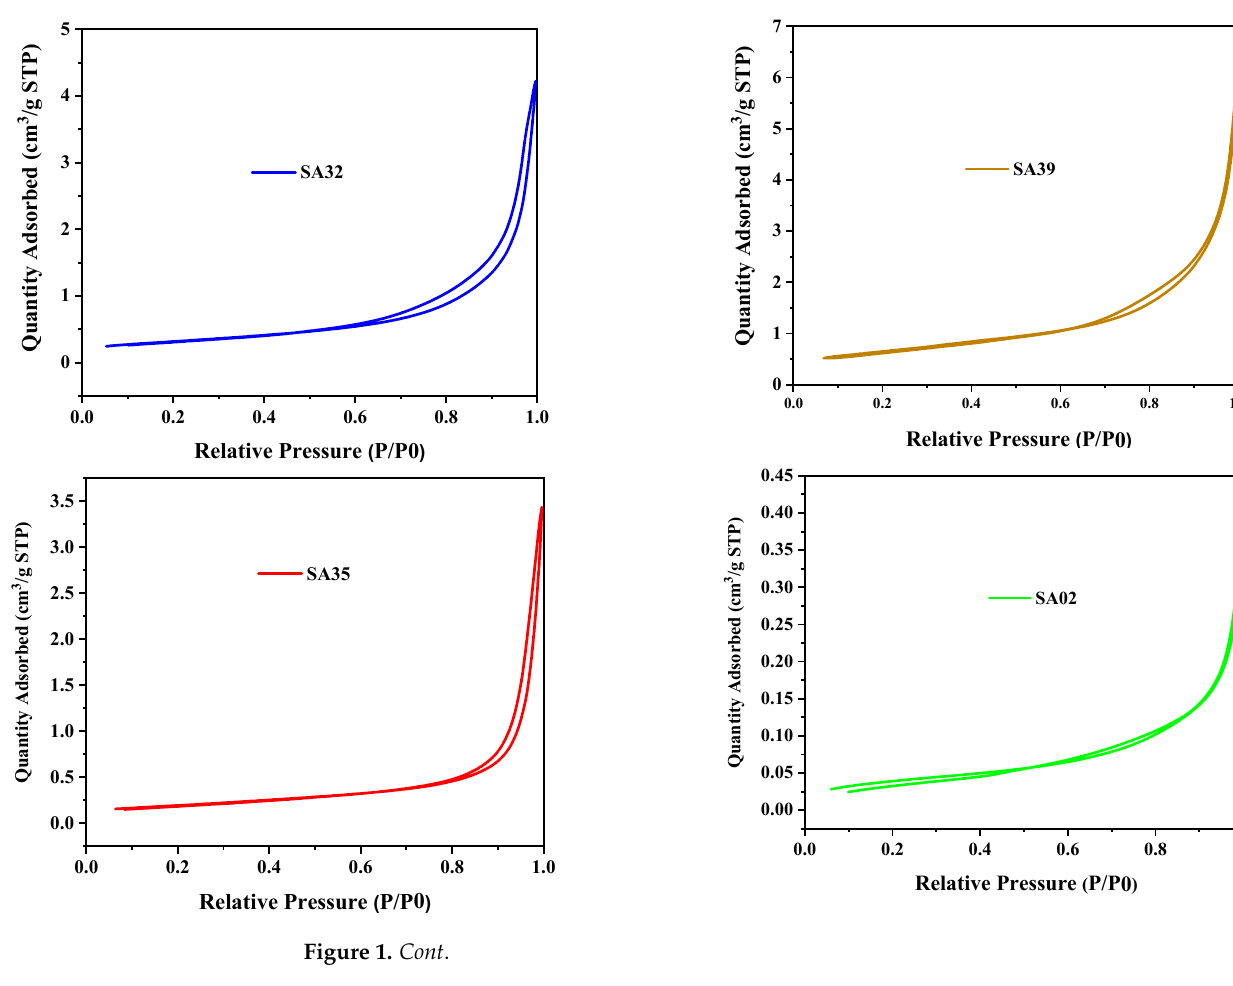
Figure 1. N 2 adsorption–desorption measurements of fresh Ni-supported catalysts. 2.2. TPR H 2 -TPR (temperature-programmed reduction) curves of the fresh catalysts are shown in Figure 2. In the range of 0–330 °C, peaks did not appear, indicating that there was no free NiO in the samples. Practically, all the samples were characterized by a single broad peak. The peaks for SA39 at 368 °C, SA35 at 460 °C, and SA02 at 470 °C could be attributed to moderate interactions between NiO and the support. Comparatively, the peak for SA32 at 671 °C could be ascribed to the strong interaction between NiO and the support. Mean- while, the peak at 825 °C for SA75 could be related to the formation of NiAl 2 O 4 , which was caused by the strong interaction of Al 2 O 3 with NiO [22] .